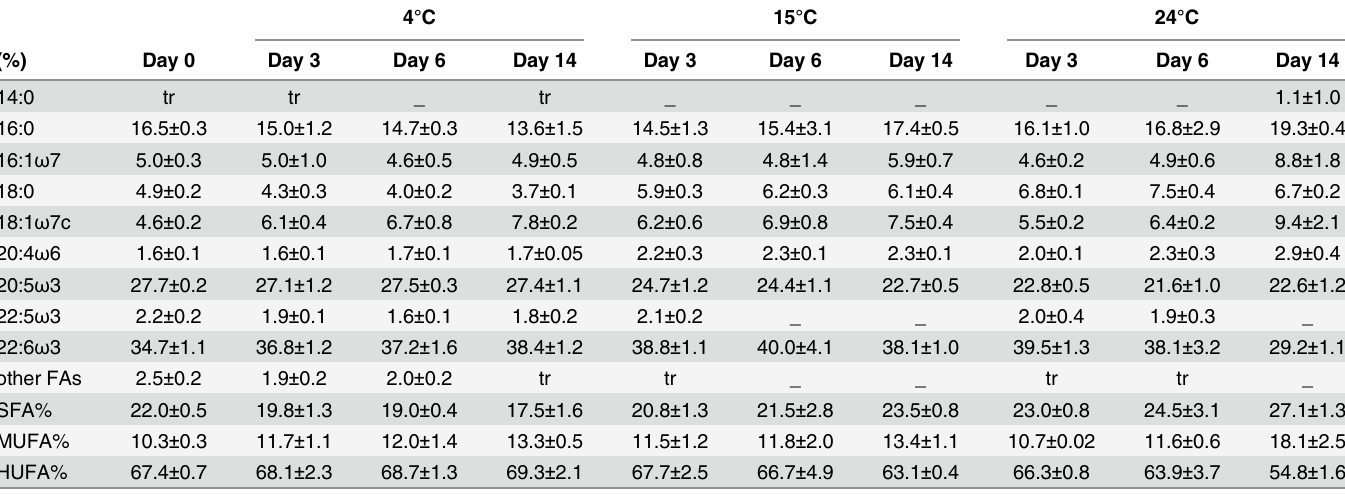
Table 1. Membrane FA composition (% ± SD) of the copepod P . littoralis prior (day 0) and after 3, 6 and 14 days of food deprivation at different tem- peratures (4, 15 and 24°C); tr, traces ( < 1%); other FAs, sum of all FAs < 1% in all